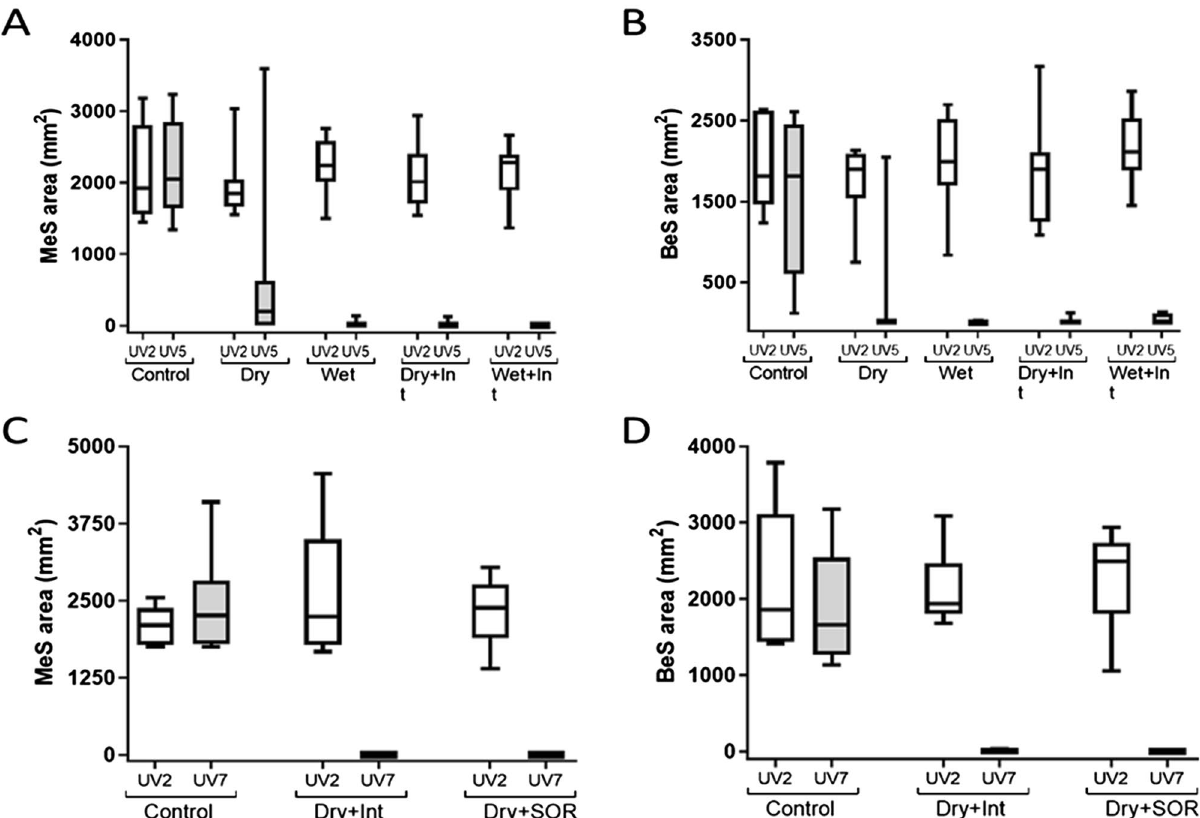
Figure 1. Surface area of simulants MeS and BeS on volunteer’s hair following application (UV2) and decontamination intervention (UV5/7) for each decontamination condition for Study 1 ( A and B ) and study 2 ( C and D ). Surface area was determined by calibrated UV photography and image analysis. Graphs show the median and inter–quartile range. Bars represent the minimum and maximum values. Int = interim